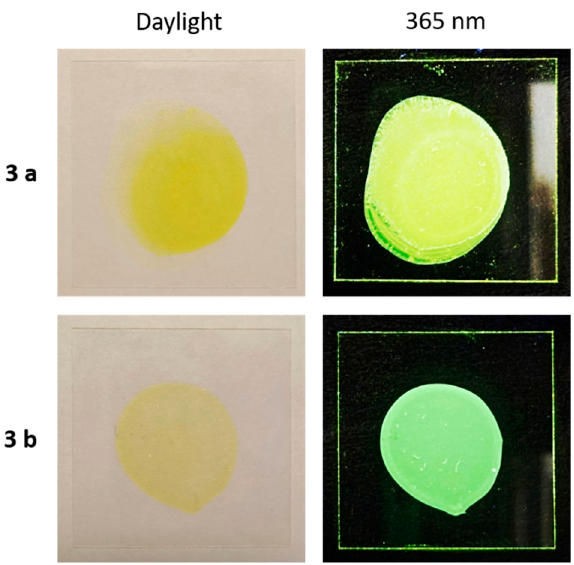
Figure 10. Photographs of polymers 3 a,b in daylight and under excitation with light 365 nm.